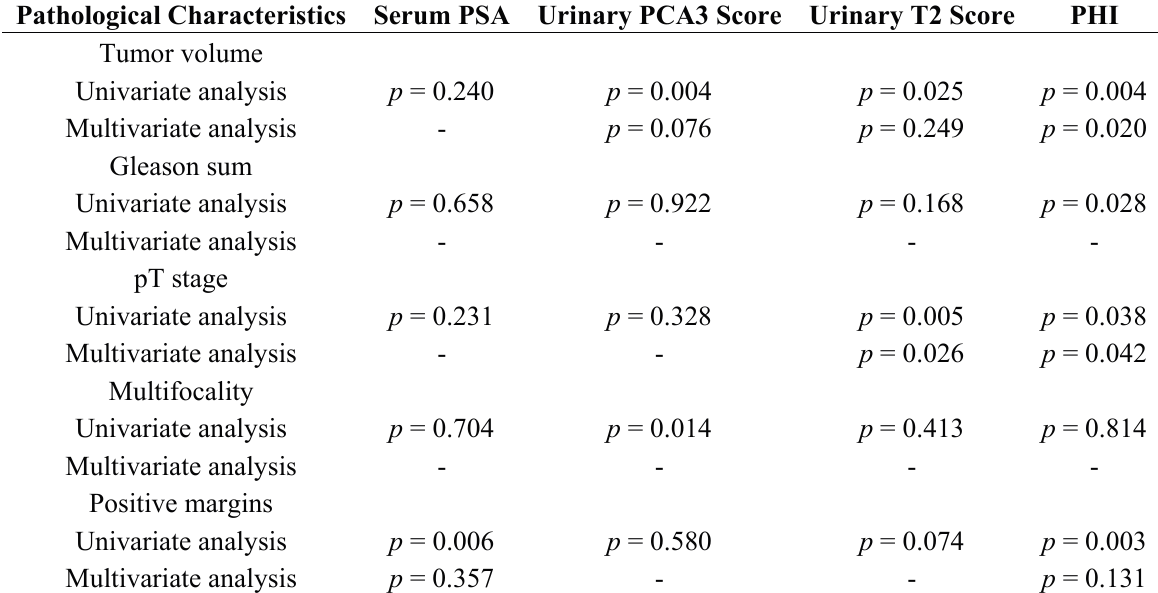
Table 3. Multivariate analyses evaluating the ability of clinico-biological variables to predict major outcomes at